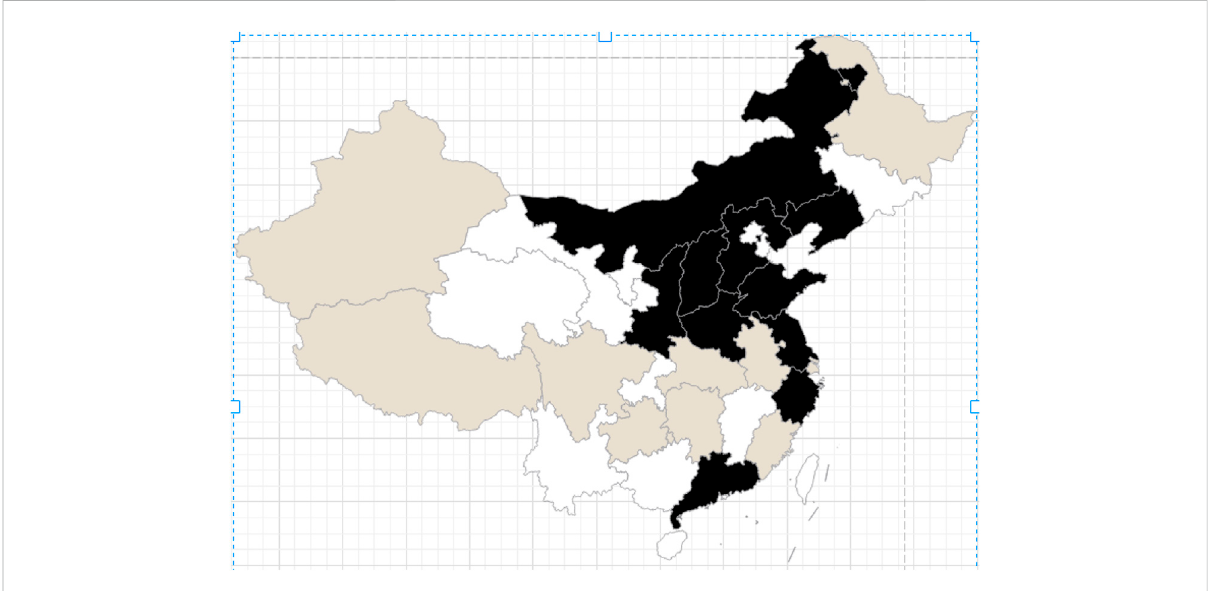
FIGURE 1 Regional differences in carbon emissions in 2010 –